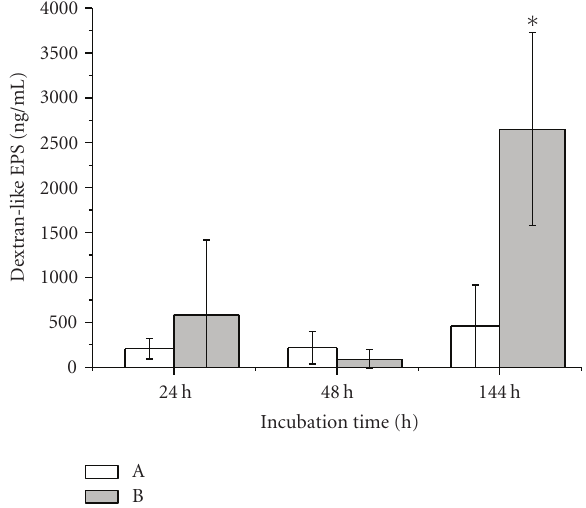
Figure 3: Lectin assay: mean values and mean-based 95% con- fidence intervals of EPSs production of S. mutans in the white rectangle medium A without sucrose and the grey rectangle medium B with 5% sucrose at 24h, 48 h, and 144 h incubation